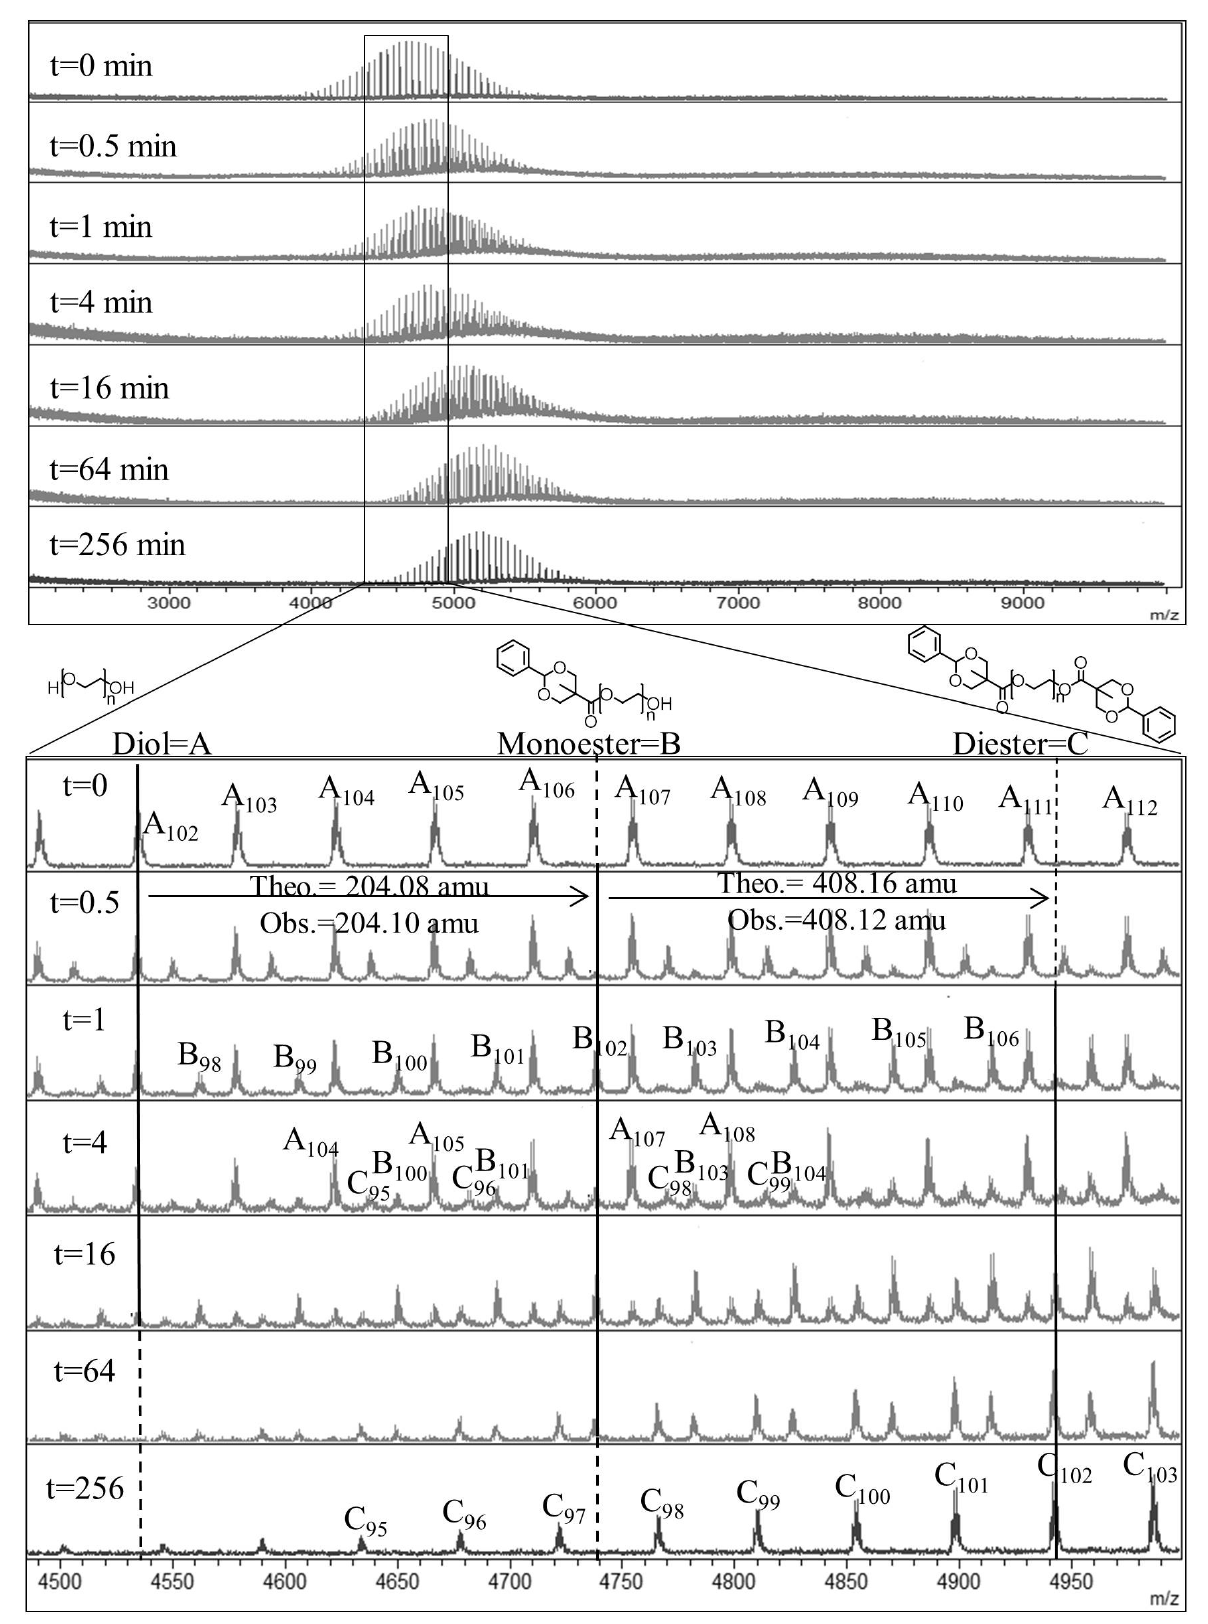
FIGURE 5 - Reaction monitoring via MALDI-ToF MS: divergent dendronization of dihydroxy PEG to afford compound